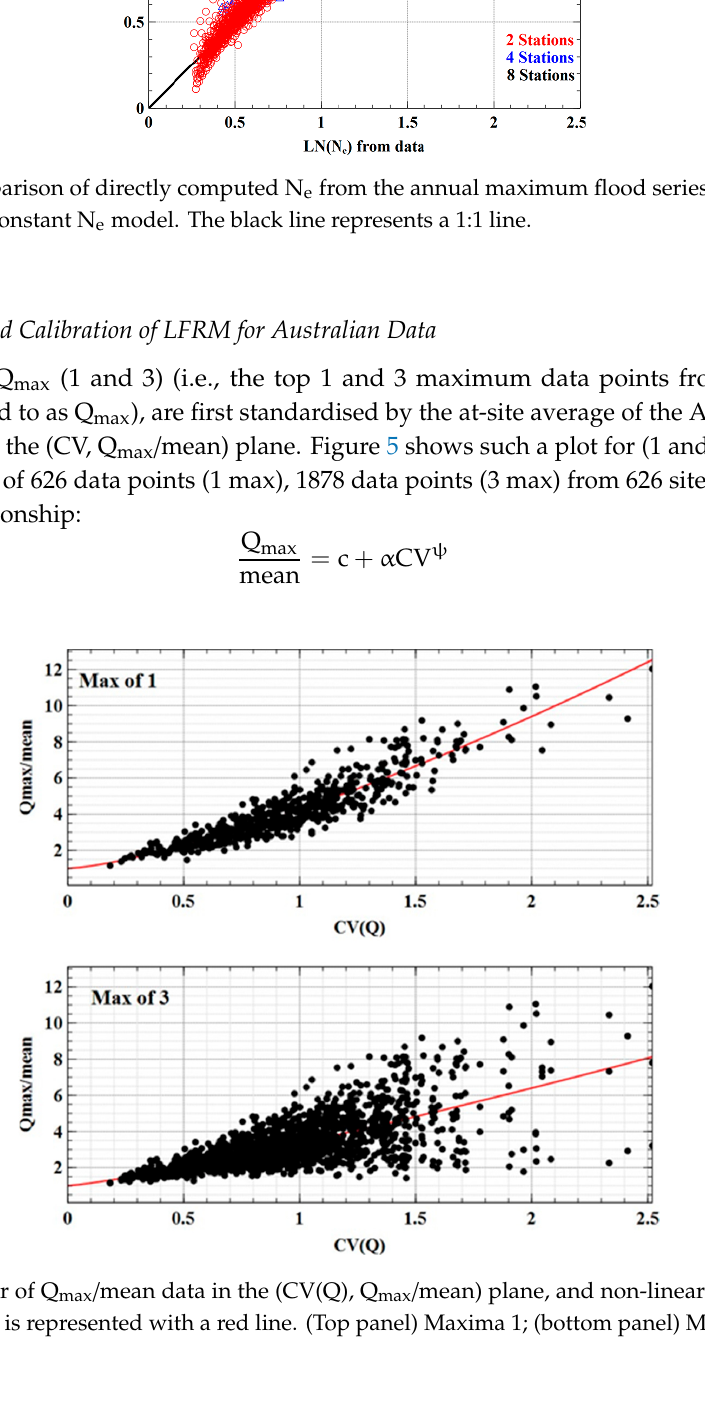
Figure 5. Scatter of Q max / mean data in the (CV(Q), Q max / mean) plane, and non-linear interpolation function, which is represented with a red line. (Top panel) Maxima 1; (bottom panel) Maxima 3.